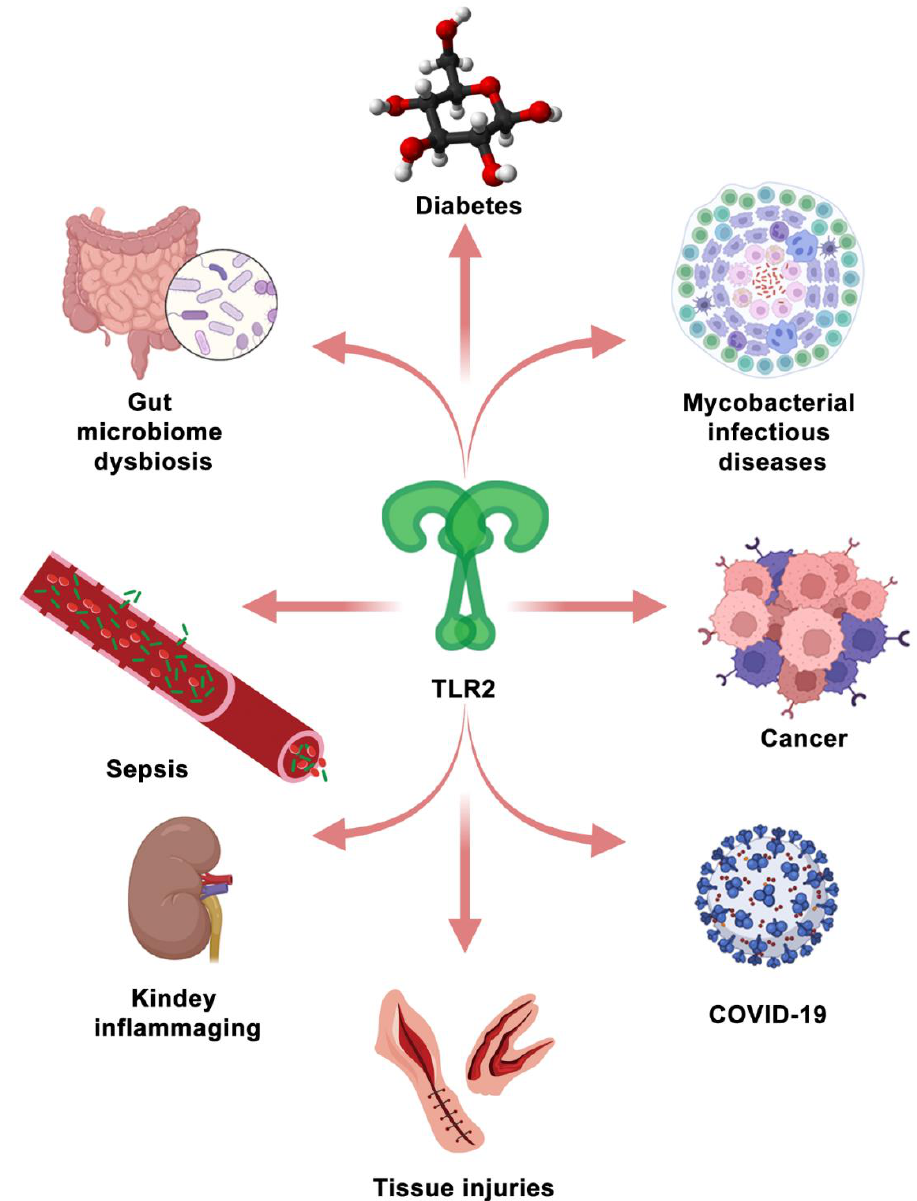
Figure 4. TLR2, which serves as a PRR, participates in the immunomodulation of some representative diseases. The Figure is made by BioRender.